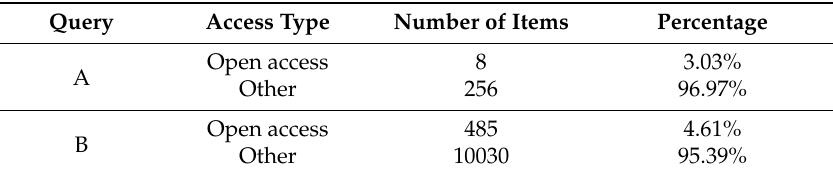
Table 1. Publications by access